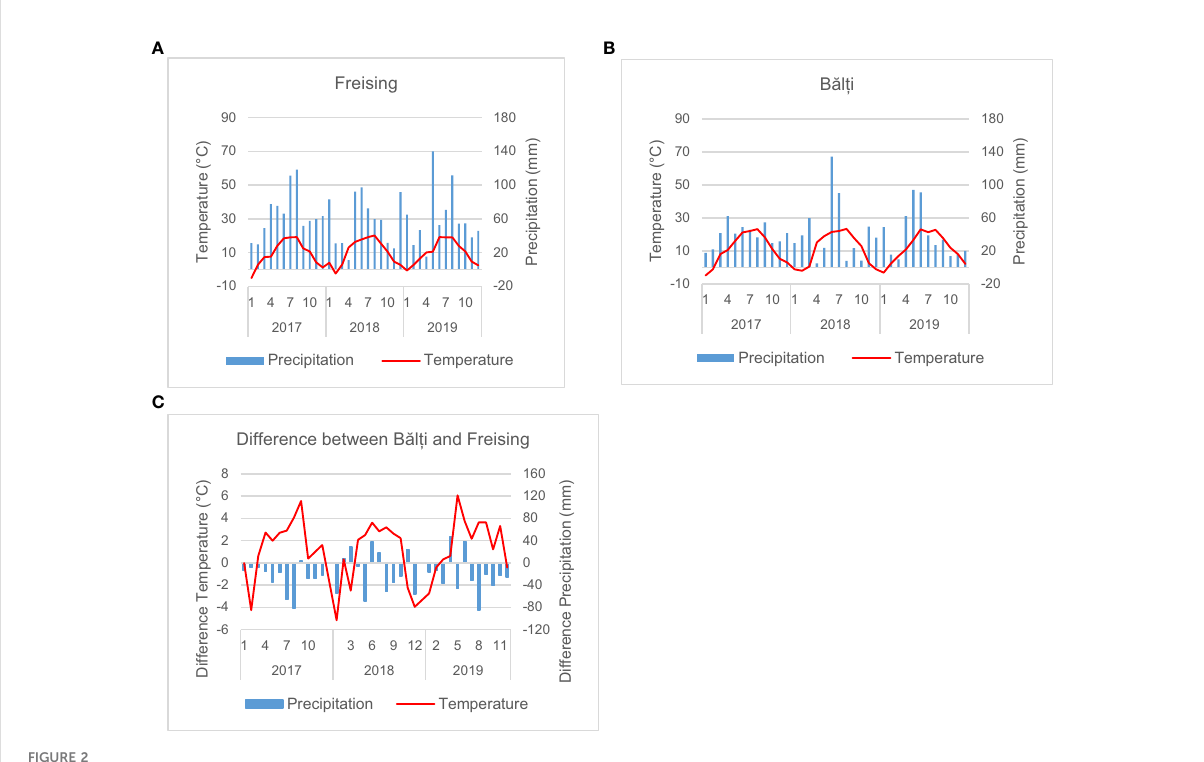
FIGURE 2 Meteorological conditions in Freising (A) and Ba ̆ l ț i (B) , and the difference between the two locations in the years 2017-2019 (C) .